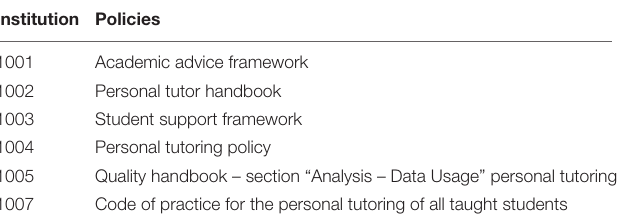
TABLE 2 | Institutions and day-to-day support